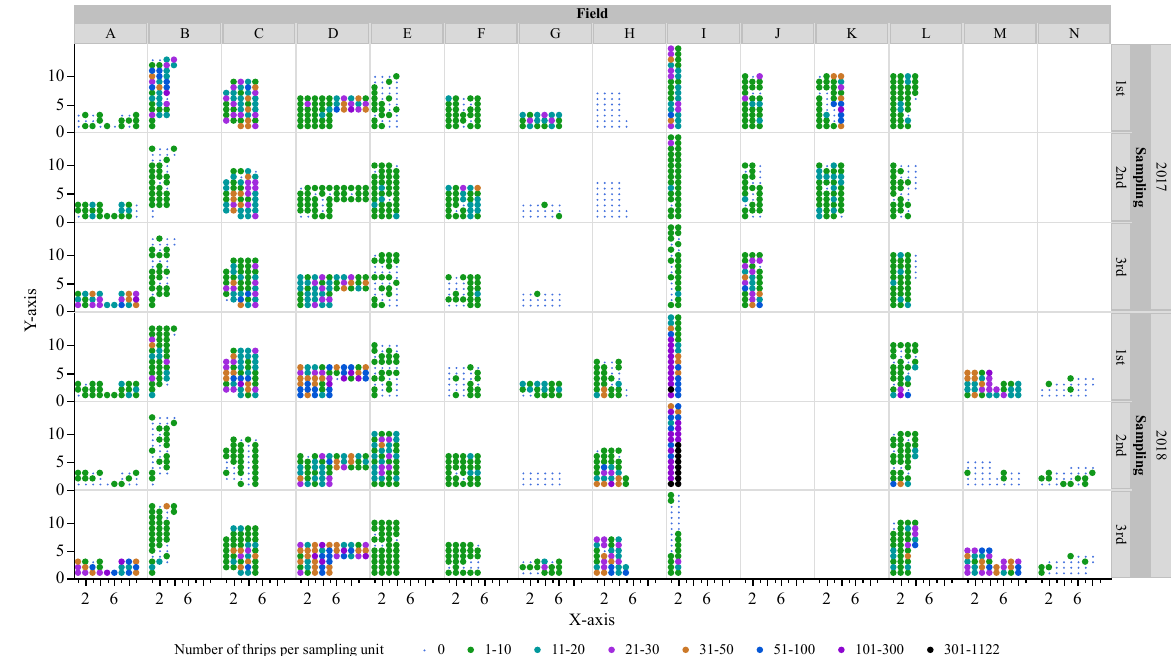
Figure 1. Field counts of Scirtothrips dorsalis per sampling unit (ten blueberry shoots) collected from fourteen blueberry fields in central Florida during summers of 2017 and 2018. Each dot represents a blueberry bush (one sampling unit) in 40 × 40 m grids.